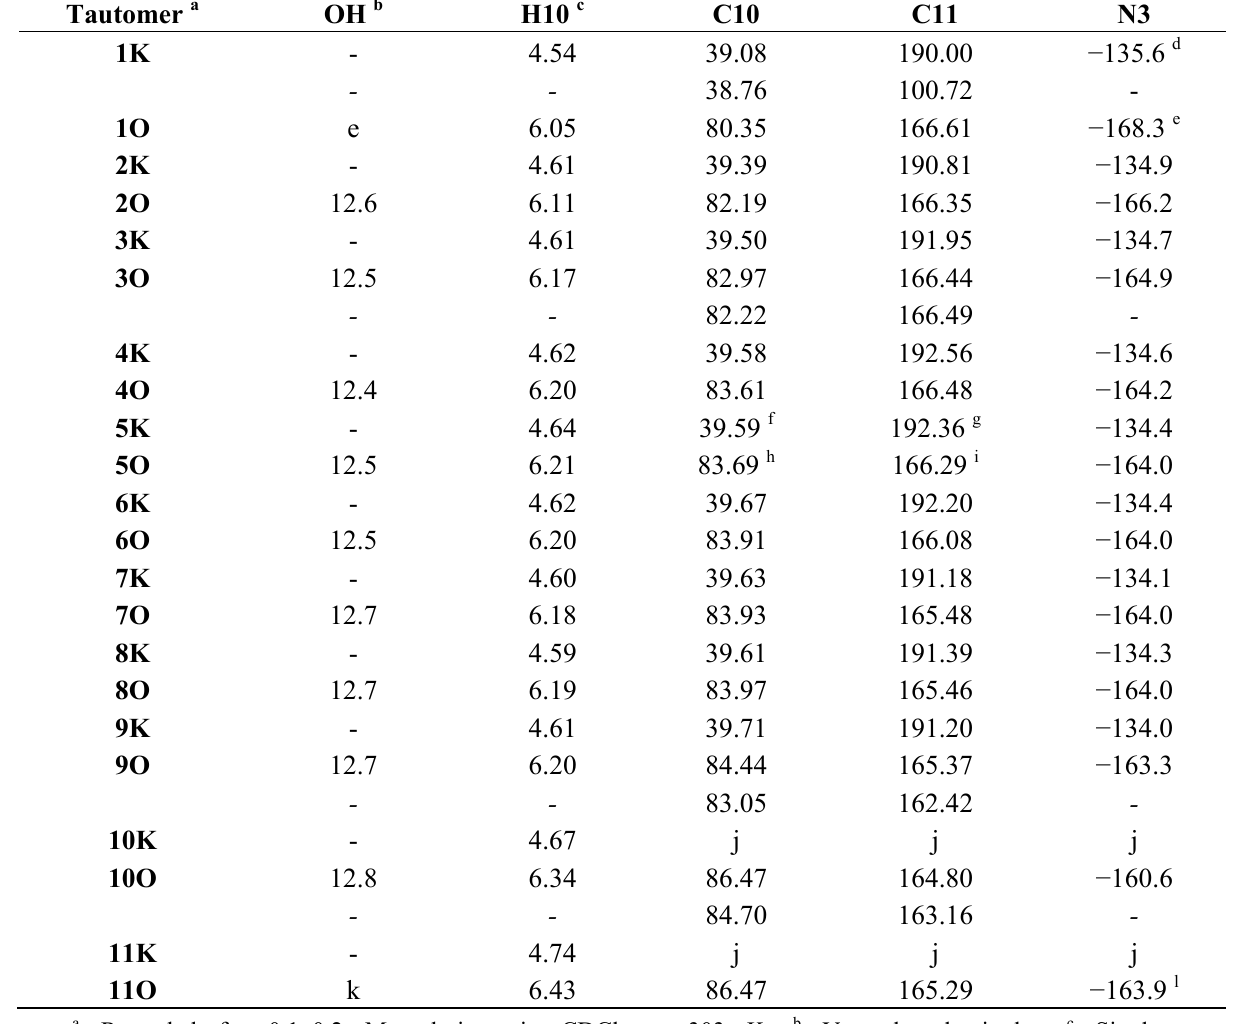
Table 4. Selected NMR chemical shifts for 1 H from TMS, 13 C from TMS, 15 N from ext. CH NO (regular characters), and 13 C CPMAS from glycine (italics) 3 2